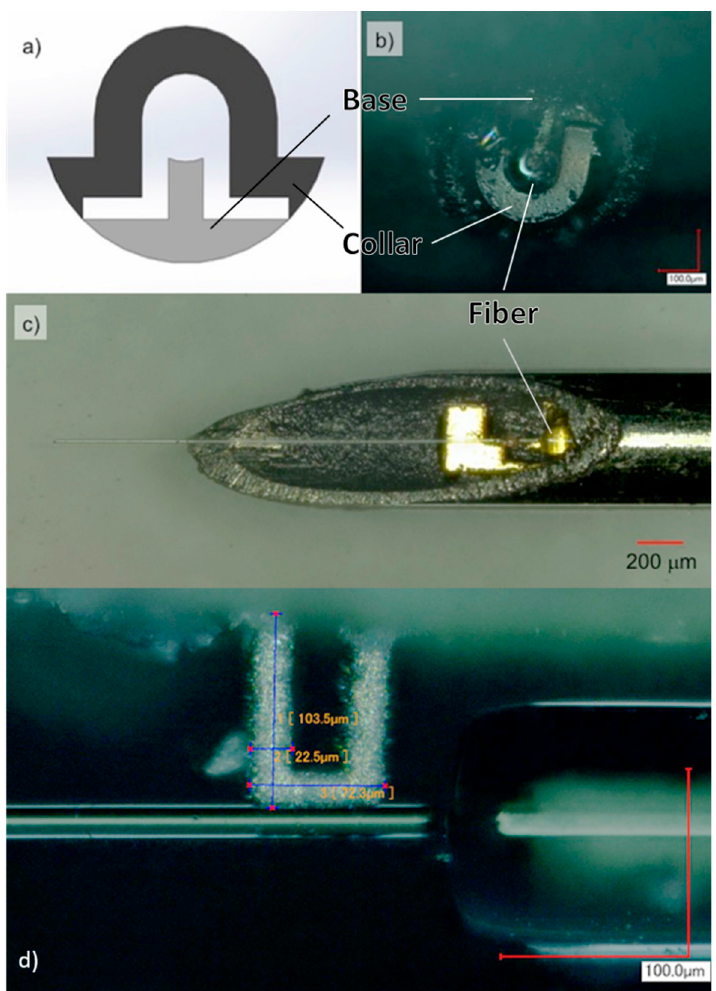
Figure 4. Collar structure to assist positioning of the scanner assembly inside the hypodermic needle: ( a ) schematic showing the two-part collar structure; ( b ) front view of the assembly (upside down relative to ( a )), clearly showing the collar structure placed in the middle of the hypodermic needle; ( c ) top view of the assembly—the collar is hidden in this view as it is inside of the housing tube; ( d ) zoomed-in view of a 100-µm-tall aluminum actuator bridge with geometric parameters.